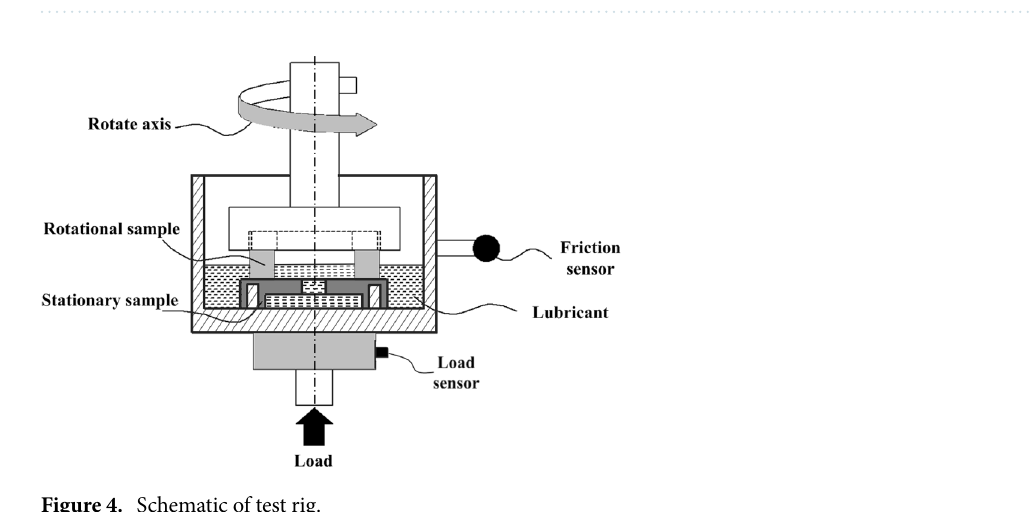
Figure 3. Topographies of the elliptical dimpled surface.